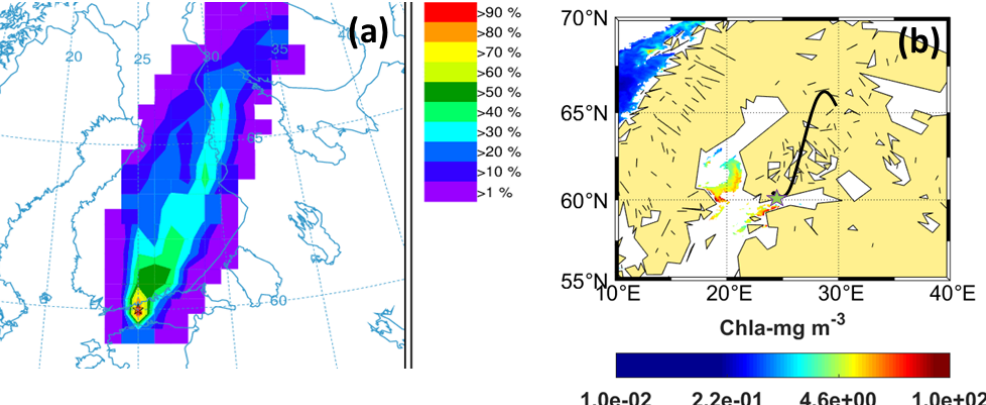
Figure 6. (a) Trajectory frequency plot (100ma.g.l., arrival time of trajectories at the measurement site: 20:00) for 24h back trajectory using GDAS (Global Data Assimilation System) meteorological input data (frequency grid resolution: 1 . 0 ◦ × 1 . 0 ◦ ). (b) Chl a concentrations (GlobColour level 3). Black line shows the trajectory direction, and the star point denotes the measurement site.